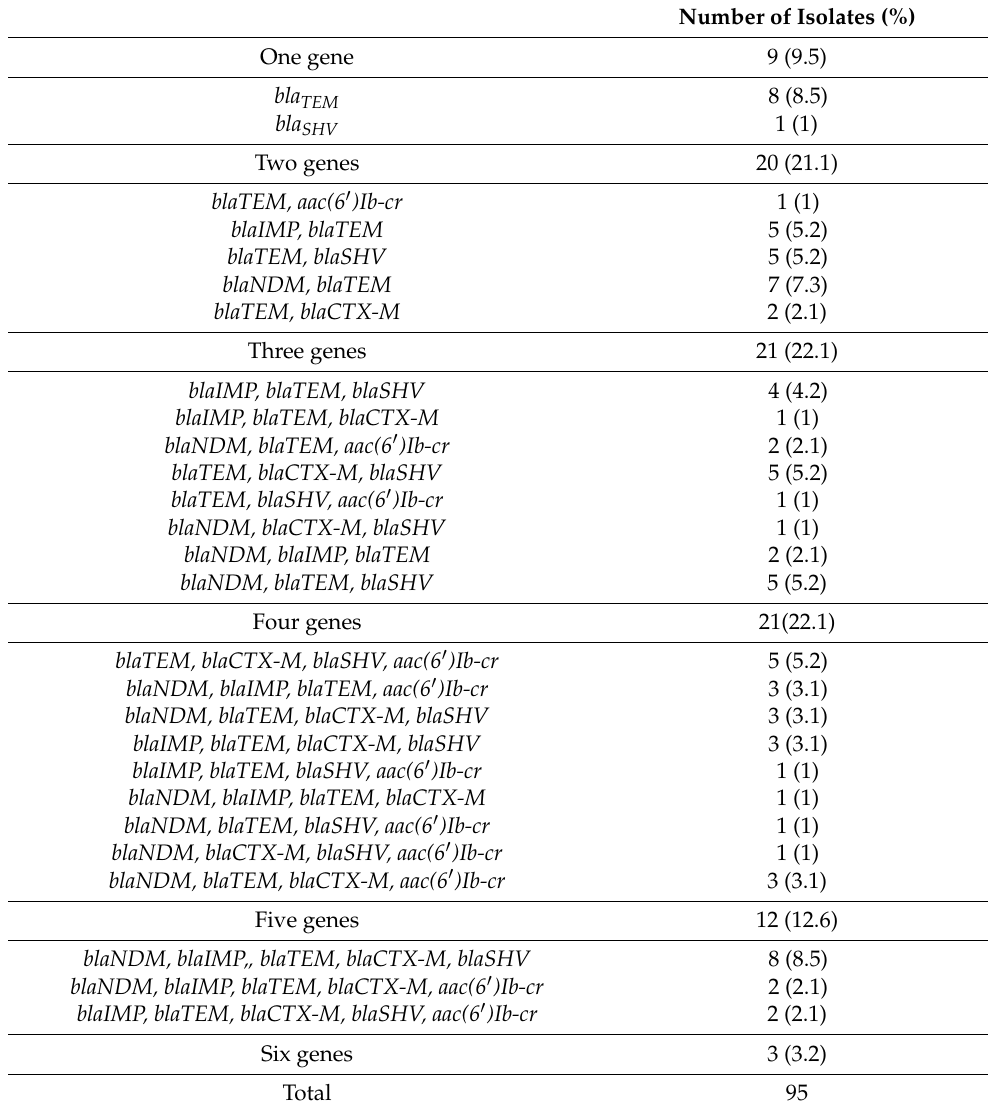
Table 8. Co-existence of different genotypes.